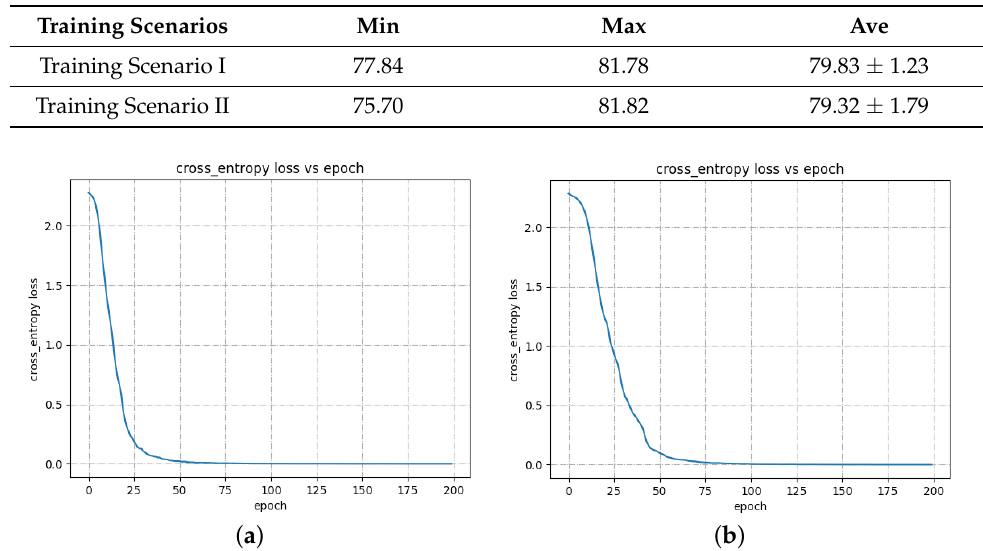
Table 3. Recognition results under different training scenarios (%).